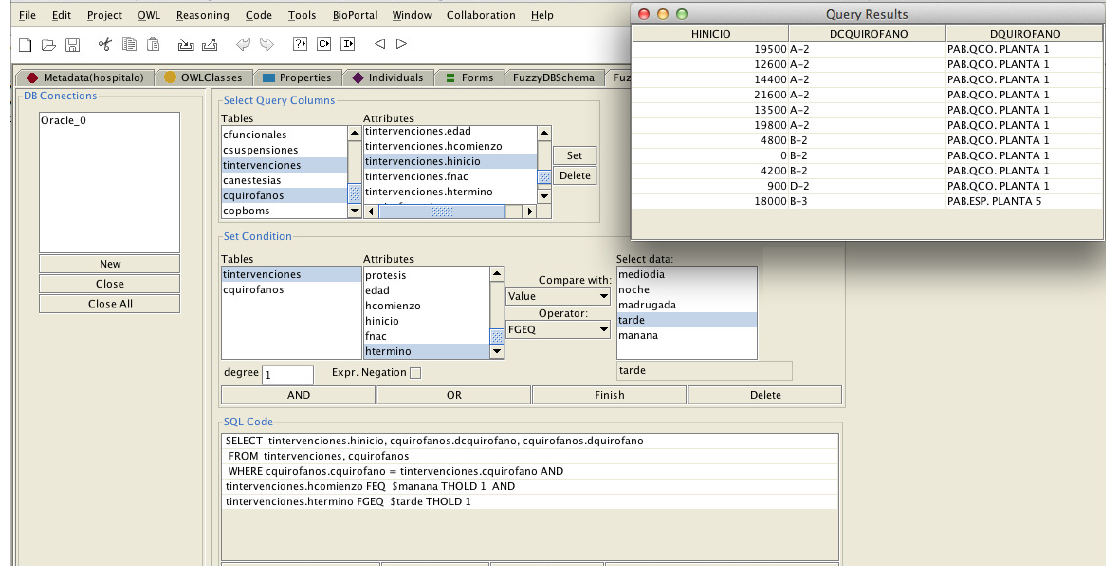
Fig. 10. Prot´eg´e plug-in to perform fuzzy